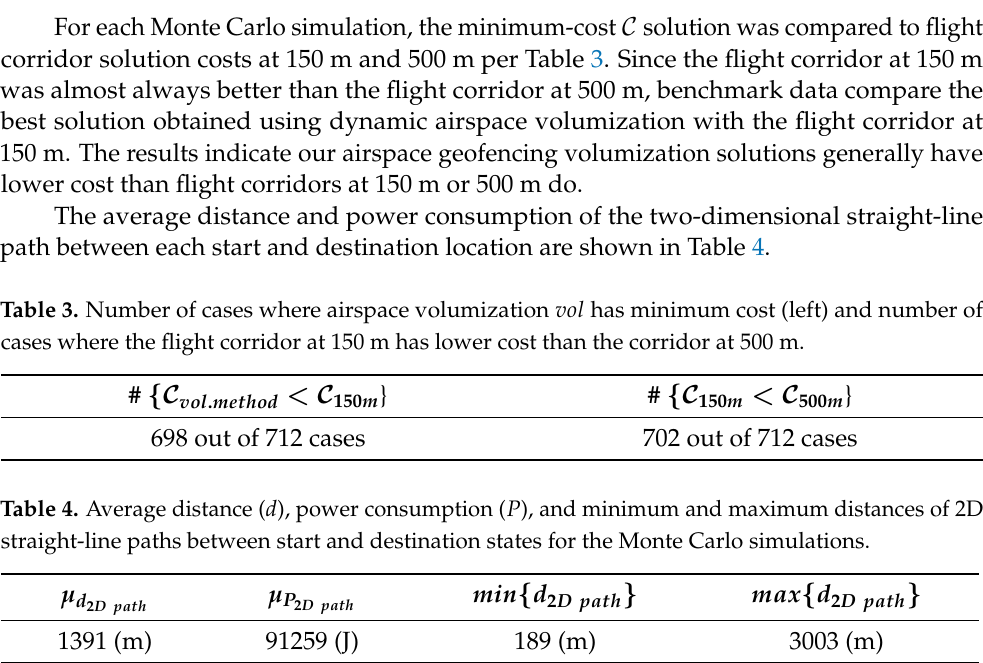
Figure 17. Example 3-D geofencing solution for a “terrain follower” flight plan solution. Polyhedra in green denote keep-out geofences around buildings near the trajectory’s keep-in geofence. The remaining 2-D polygons denote keep-out geofences around buildings that are more distant from the sUAS flight path.